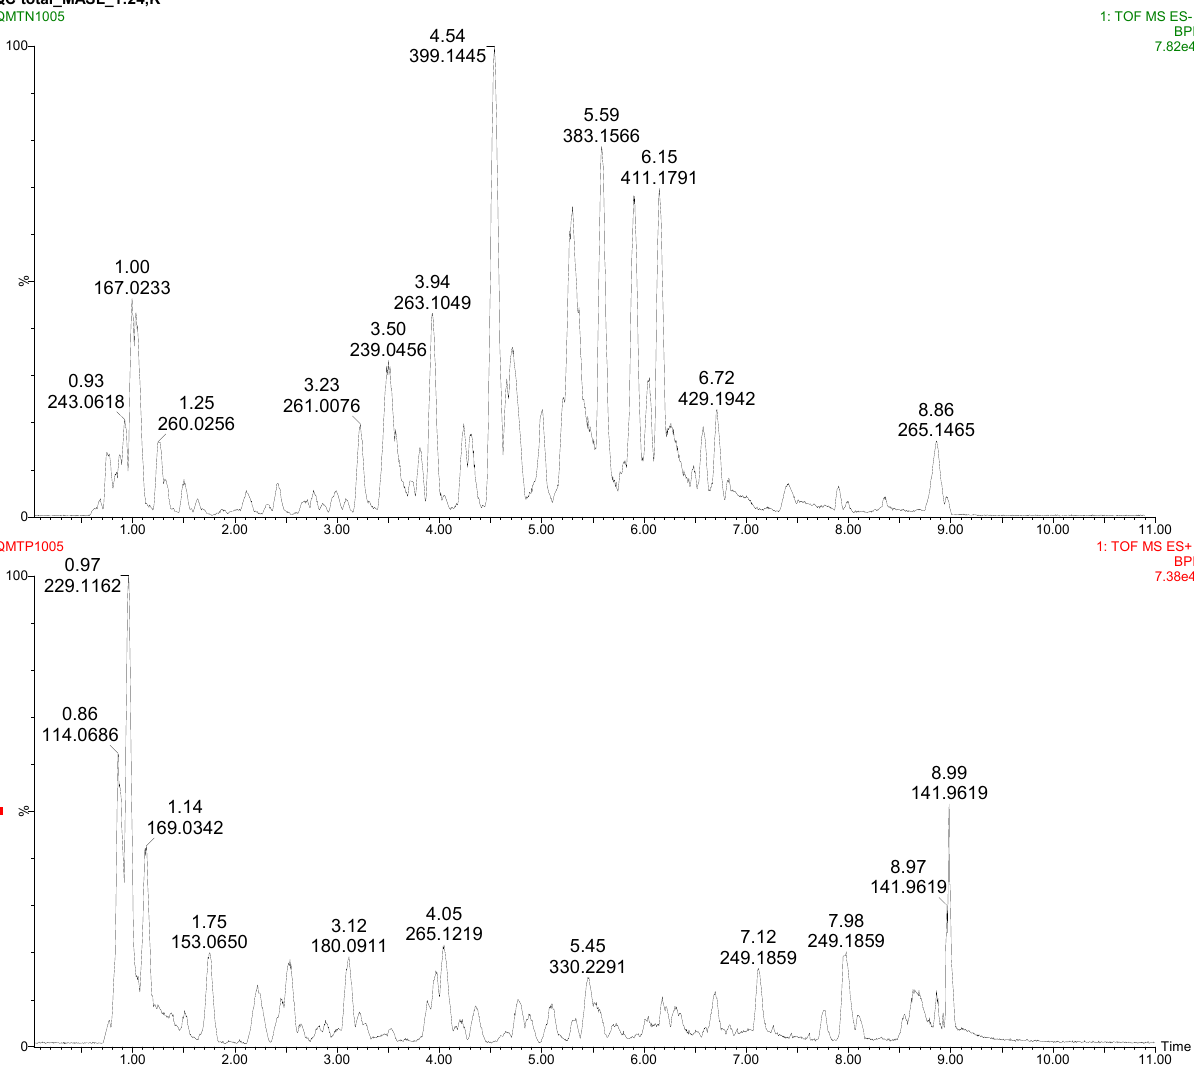
Figure 1. Chromatographic profiles (base peak chromatograms) of a Quality Control sample: negative ionization mode ( upper side ) and positive ionization mode ( lower side ).